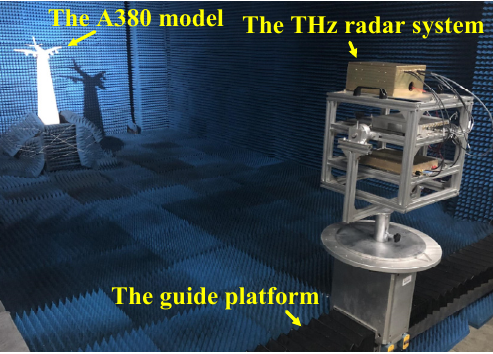
Figure 11. The experimental configuration.